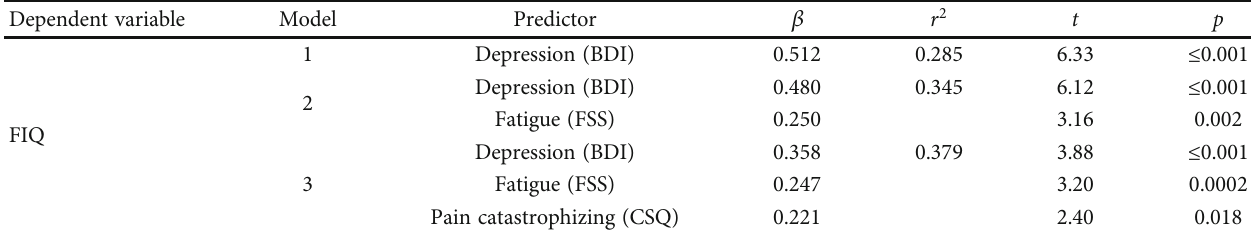
Table 2: Regression analysis for the prediction of FIQ score by the emotional and clinical variables evaluated.